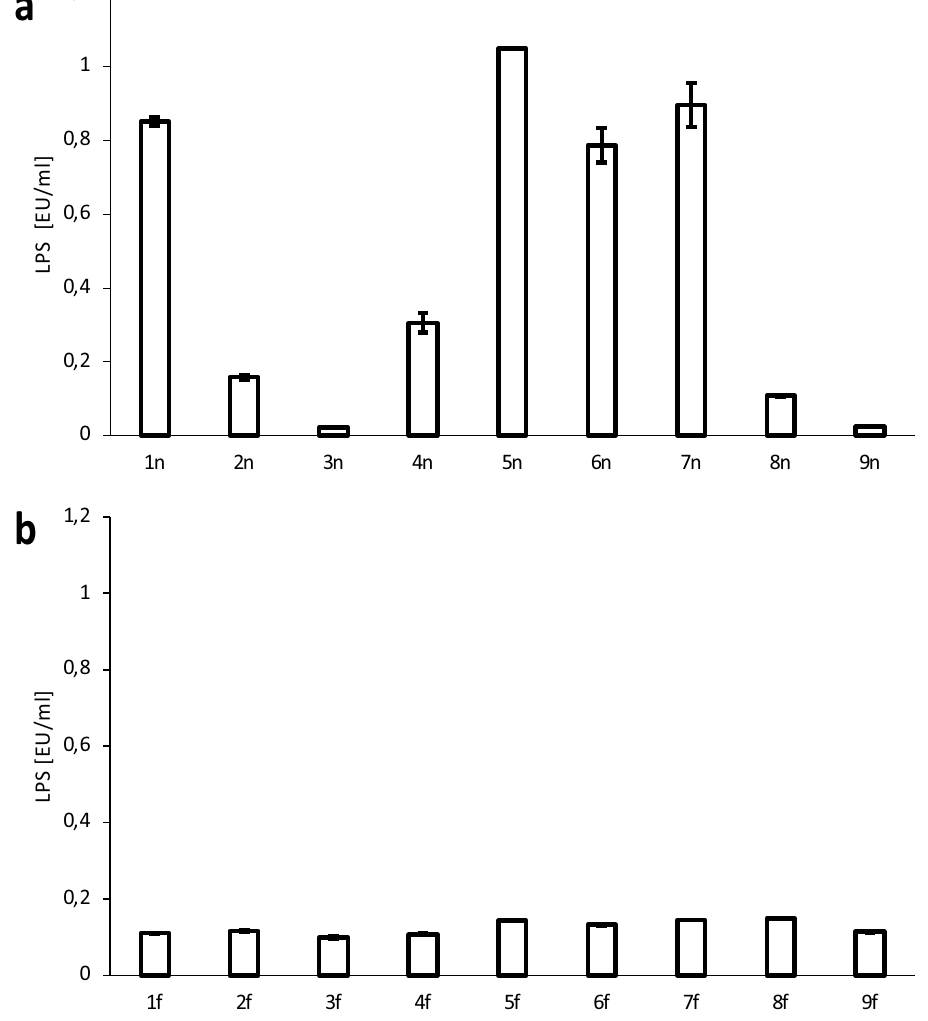
Figure 3. LPS content in native plant extracts 1n – 9n ( a ) and extracts after ultrafiltration 1f. – 9f. ( b ) at the concentration 50 μg/mL. Analytical sensitivity: 0.1